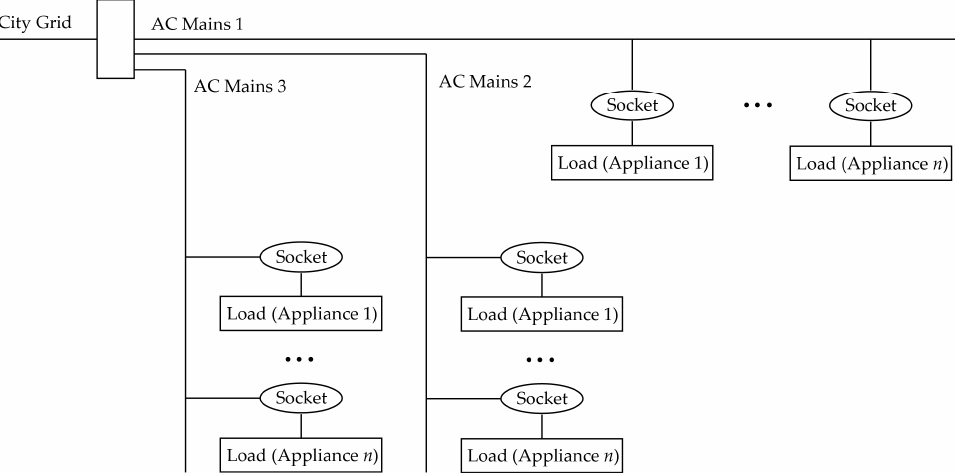
Figure 3. Typical topology for residential loads.